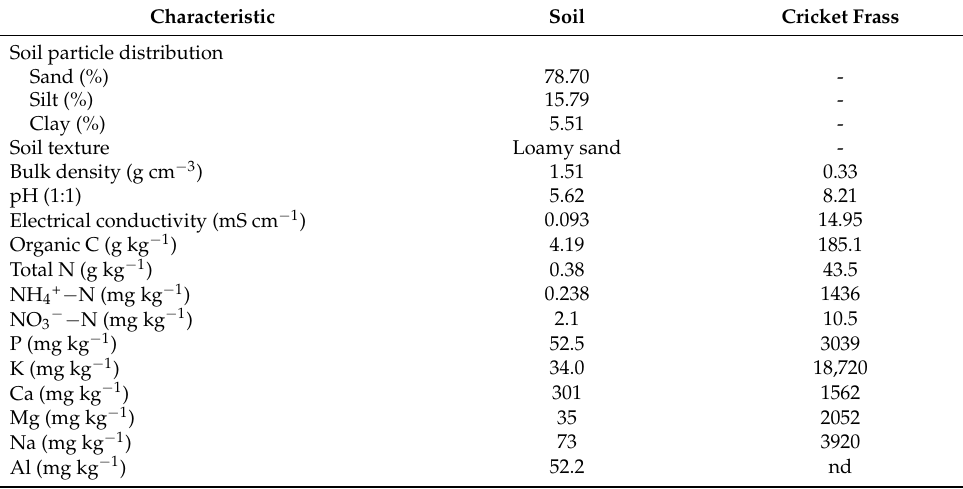
Table 1. Initial characteristics of soil and cricket frass used in the experiment. Characteristic Soil Cricket